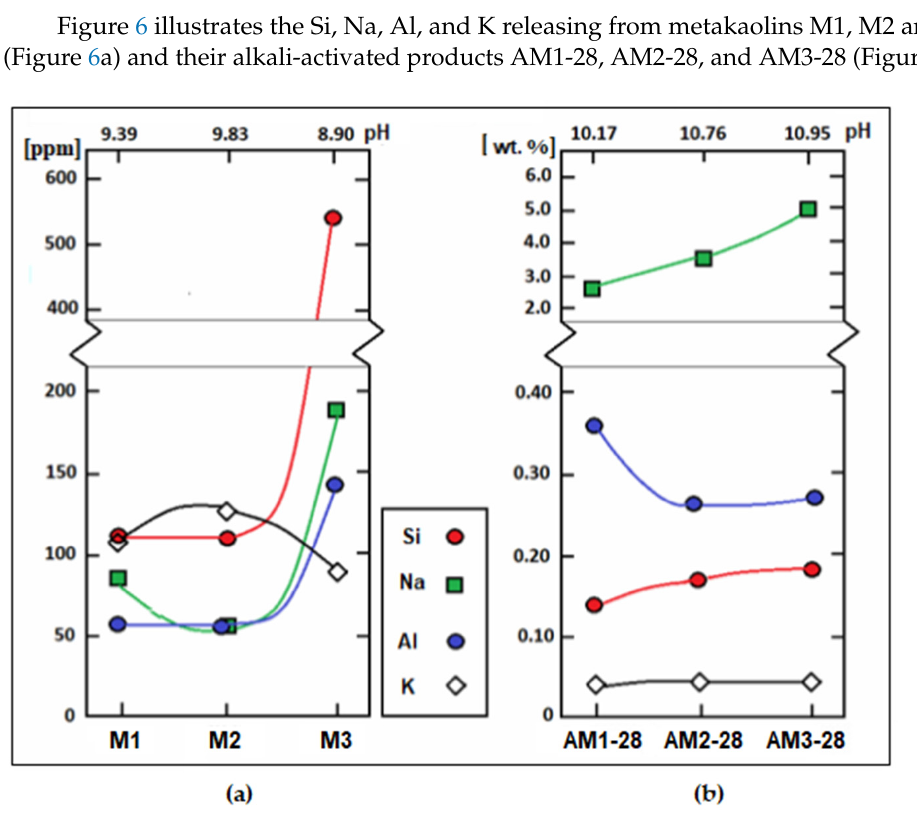
Table 3. Metakaolins and alkali-activated metakaolins AM-28: elements (wt. %) leached at pH in distilled water.